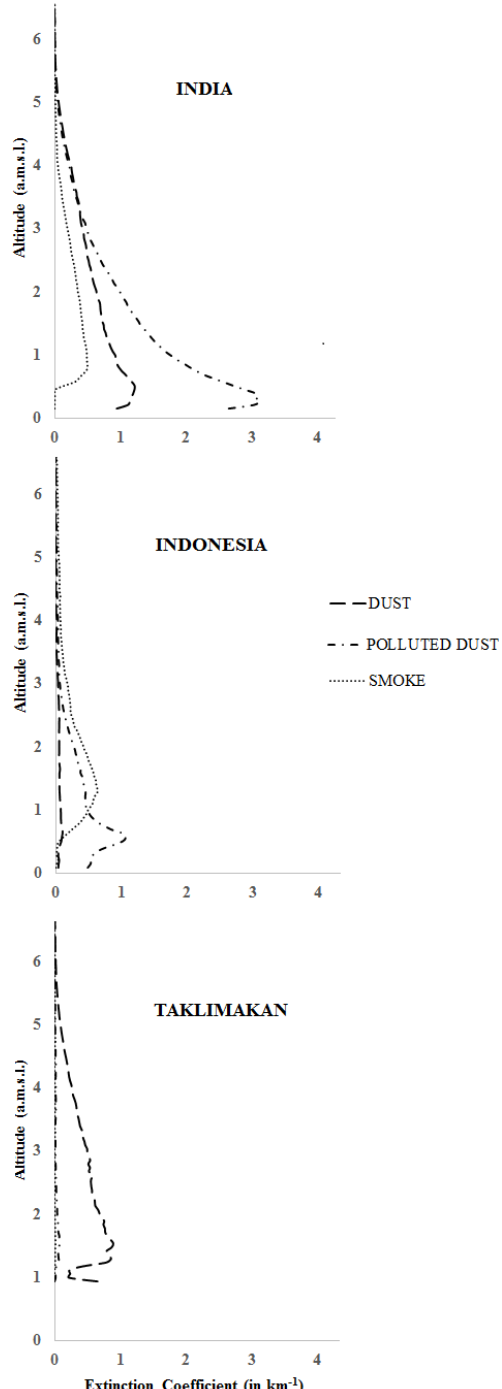
Figure 1 Vertical distribution of dust, polluted dust and smoke over three different regions of